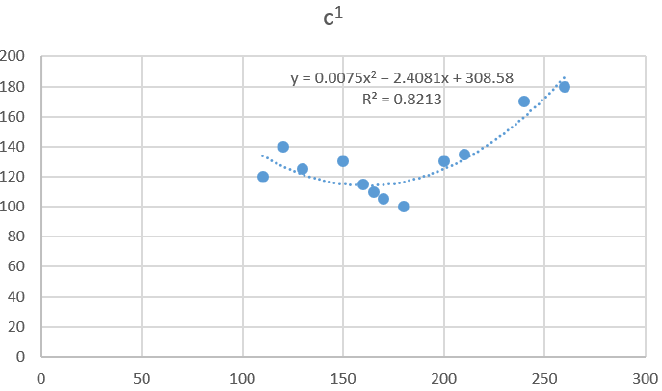
Figure 1. Analytical cost dependency on the size of the stock of the first type.